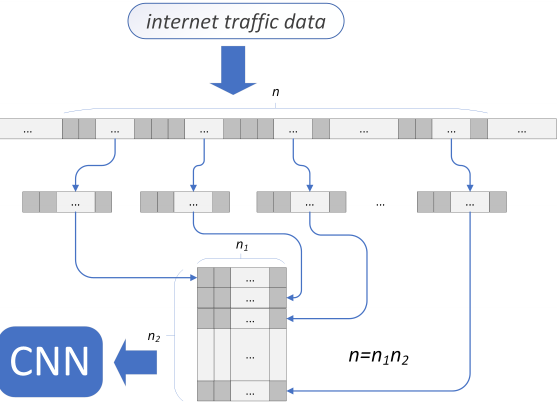
Figure 4. Introducing the second dimension by wrapping the network traffic